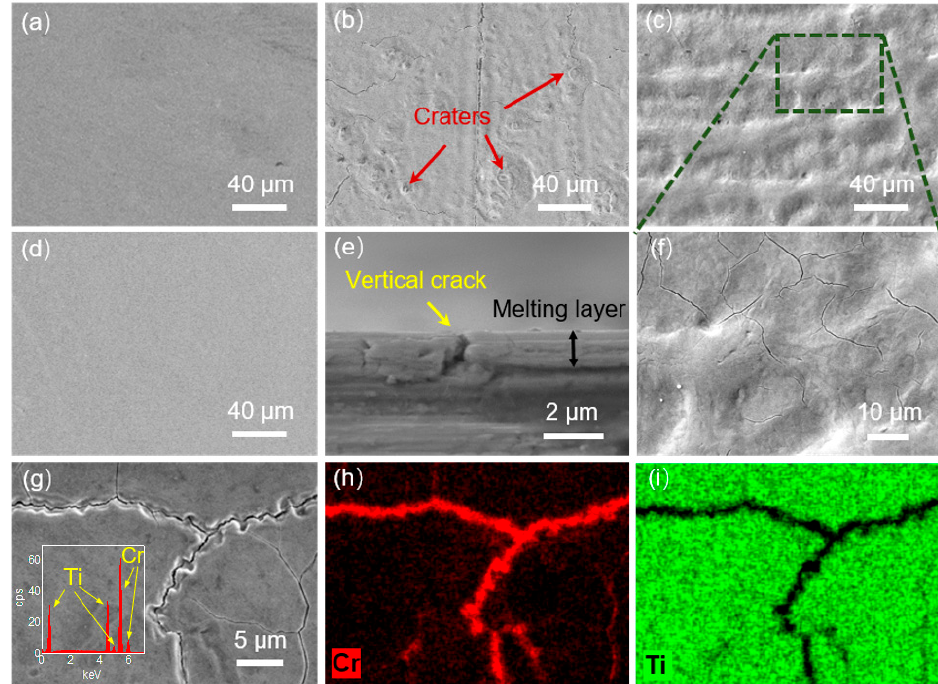
Figure 7. The surface SEM images of ( a ) unirradiated sample, ( b – d ) irradiated samples with 1, 5, and 20 pulses of IPIB treatment, respectively. ( e ) Cross sectional morphology of vertical crack on the irradiated sample. ( f ) Local enlarged view of the area marked by box in ( c ). ( g – i ) EDS mapping of the cracks on the irradiated sample